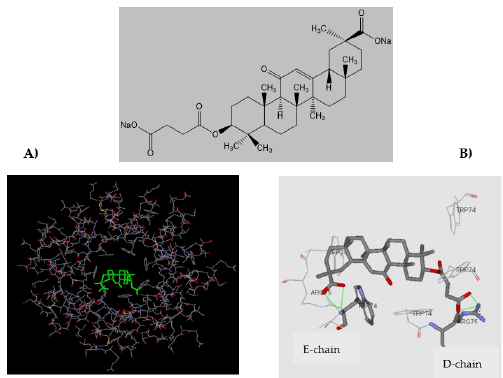
Figure 8. Docking of Carbenoxolone (CBX). The lower-energy pose of CBX in the extracellular domain of the PANX1 channel (panel A ). Particular of the hydrogen bond interactions between CBX and the Arg75 of E- and D-chain (panel B ).